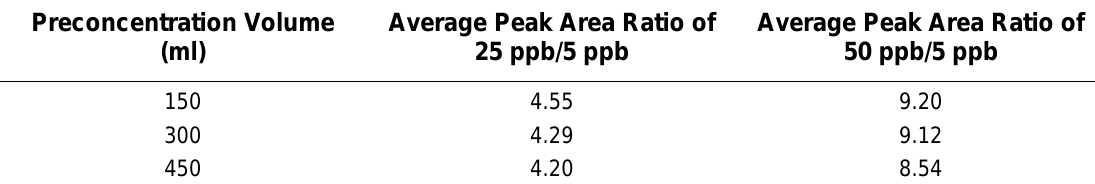
Comparisons of Average Peak Ratios at Different Preconcentration